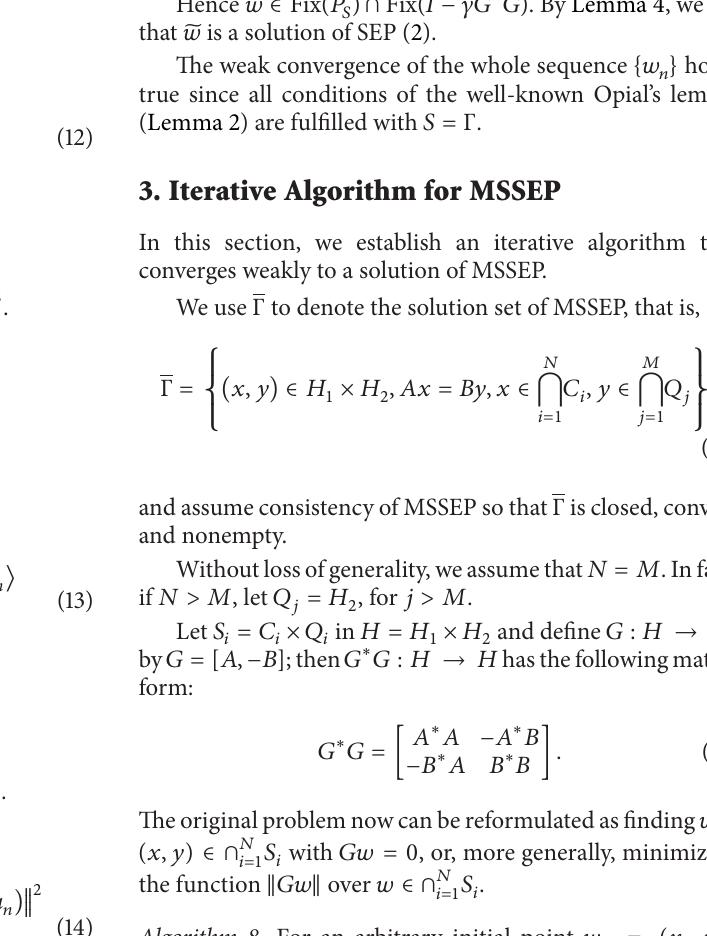
Algorithm 8. For an arbitrary initial point 𝑤 0 = (𝑥 0 , 𝑦 0 )